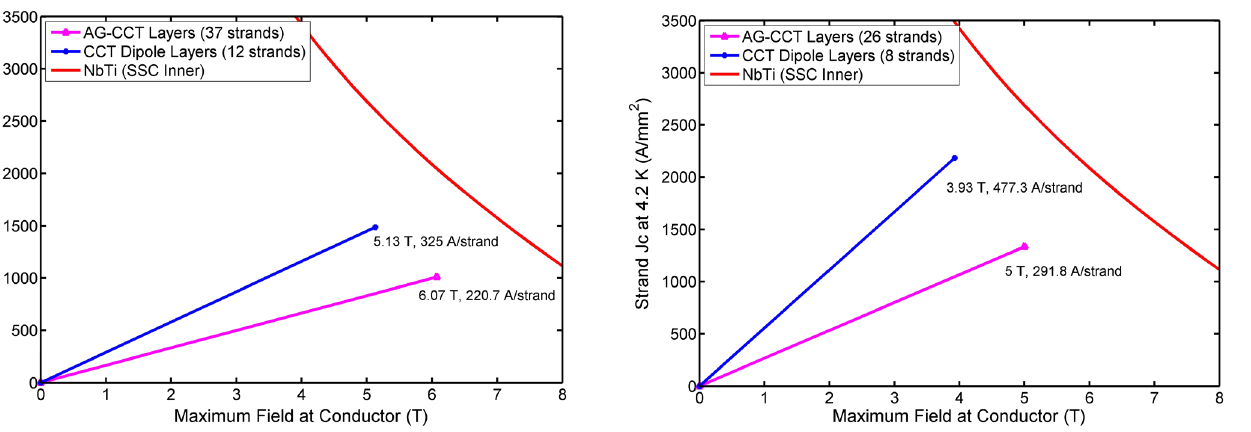
FIG. 9. The short sample in the superconductor using SSC inner NbTi strand is shown for both the AG-CCTand CCT dipole layers of the 90 degree bend (B3). Both sets of layers have a current margin of more than 20% for the given number of strands.